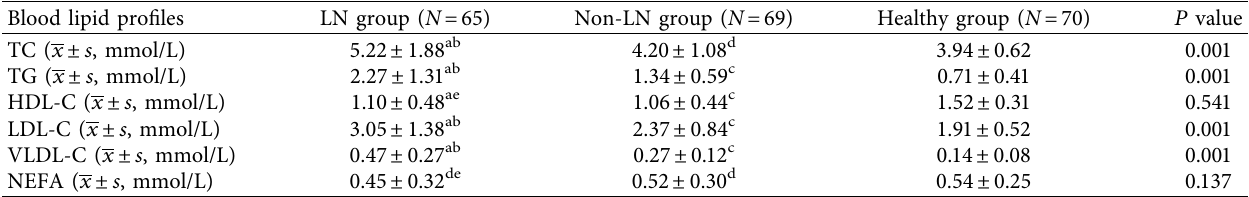
Table 2: Blood lipid profile levels of the study